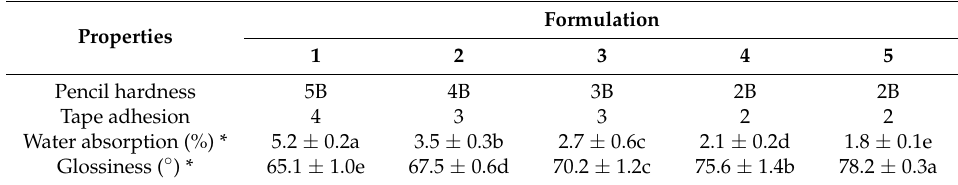
Table 3. The effect of EFCSA content on coating properties.